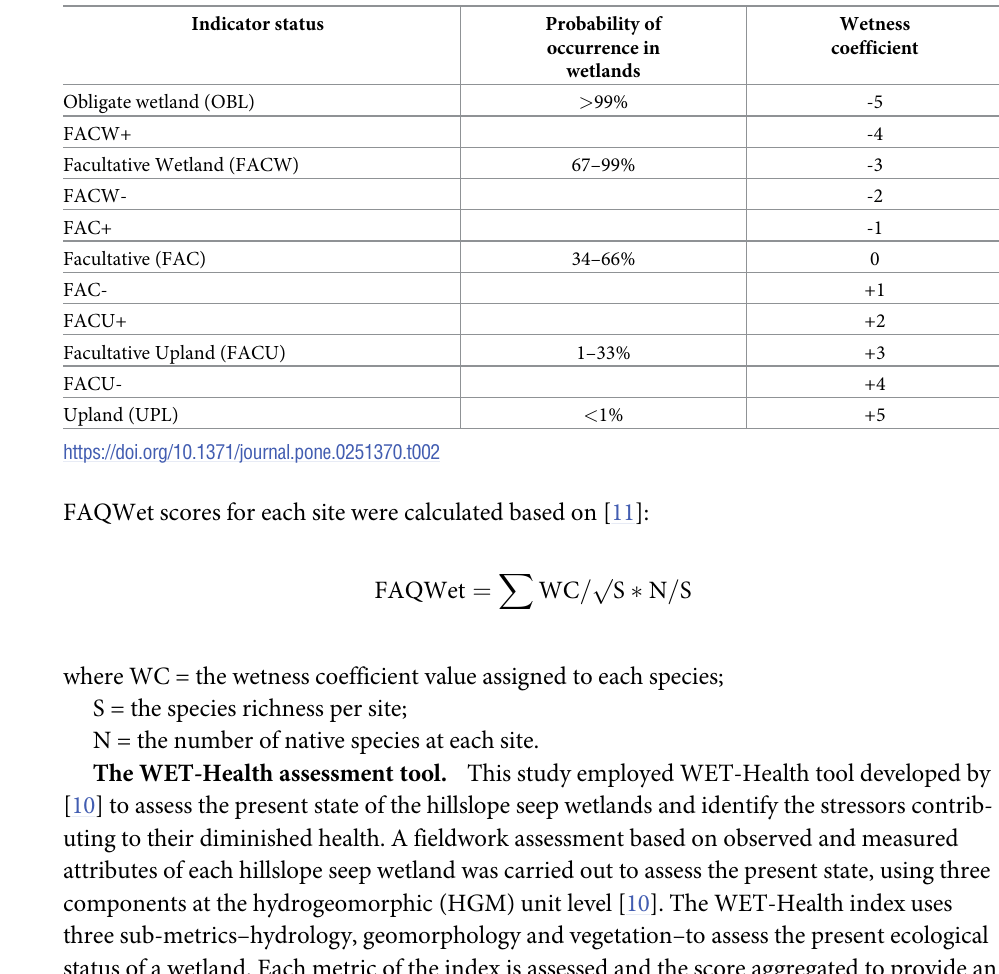
Table 2. Wetness coefficients based on wetland indicator status categories